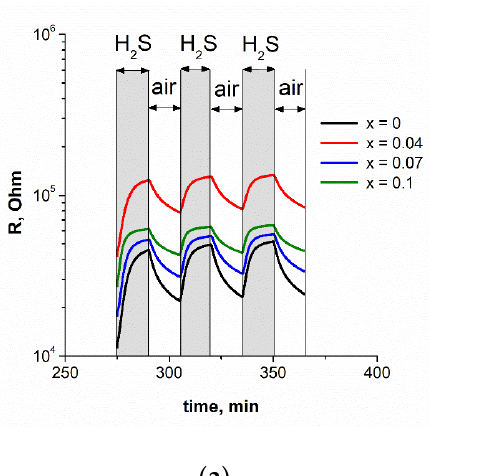
Figure 5. Dynamic response of Co 3 O 4 and Ni x Co 3 − x O 4 based gas sensors in the periodic presence of H 2 S (1 ppm): ( a ) in dry air at 210 °C; ( b ) in humid air (60% R.H.) at 90–300 °C.